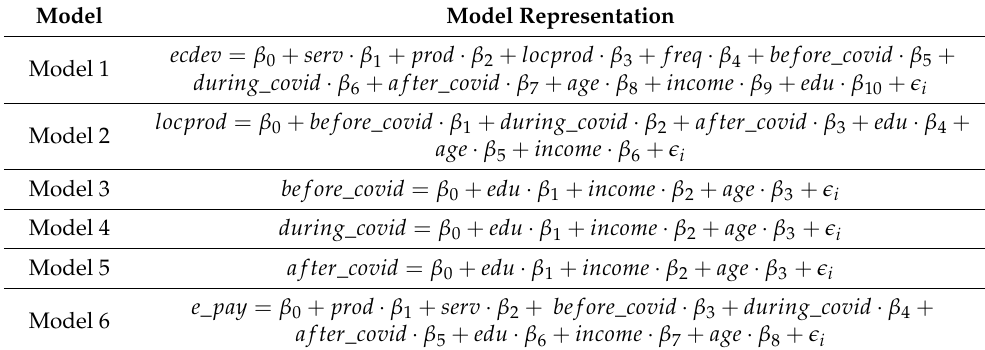
Table 1. Model description.